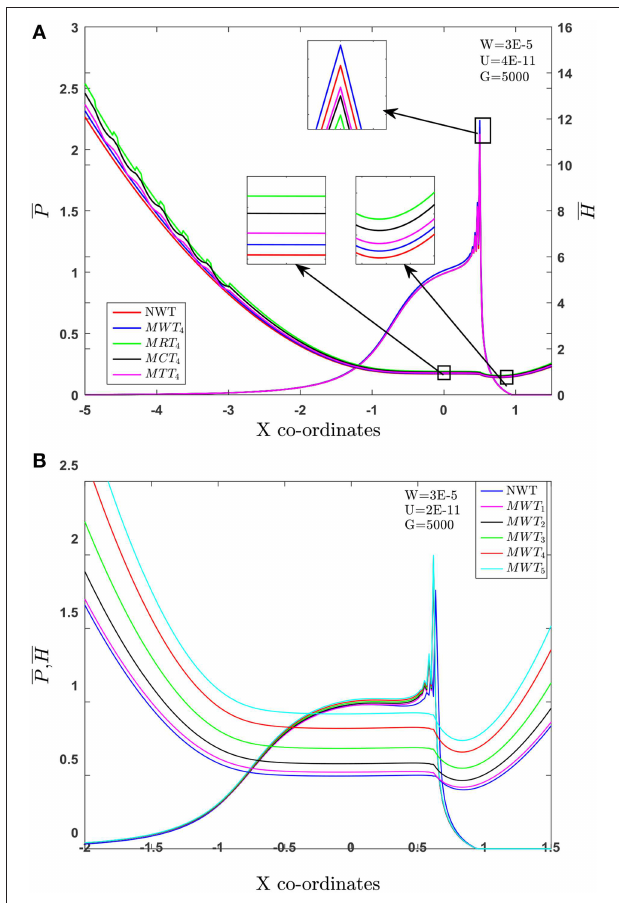
FIGURE 10 | Effect of MHD lubricant and micro texture shapes in inlet zone of EHL line contact at W = 3 × 10 − 5 ; U = 2 × 10 − 11 ; G = 5,000. (A) Hm = 4. (B) Without texture and Hm